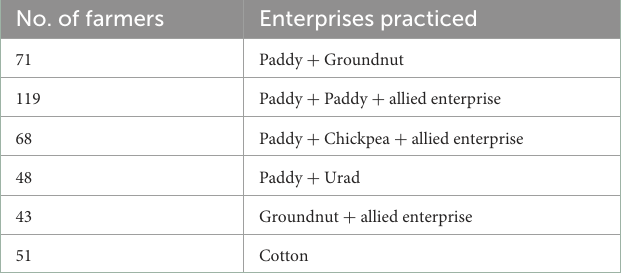
TABLE 1 Number of farmers practicing crops and allied enterprises in the study area. No. of farmers